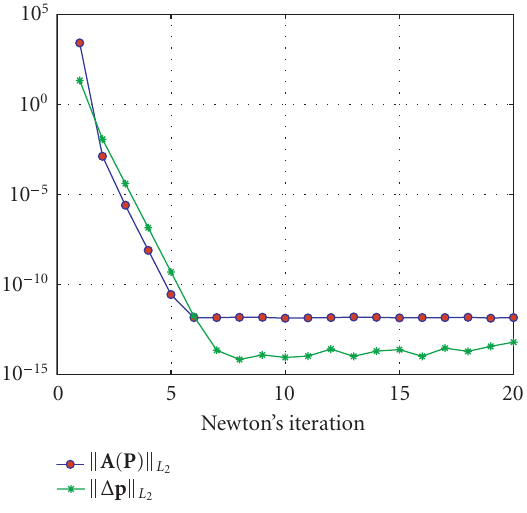
Figure 4.14 . Example 4.4: residual and di ff erence vector versus Newton’s iteration.